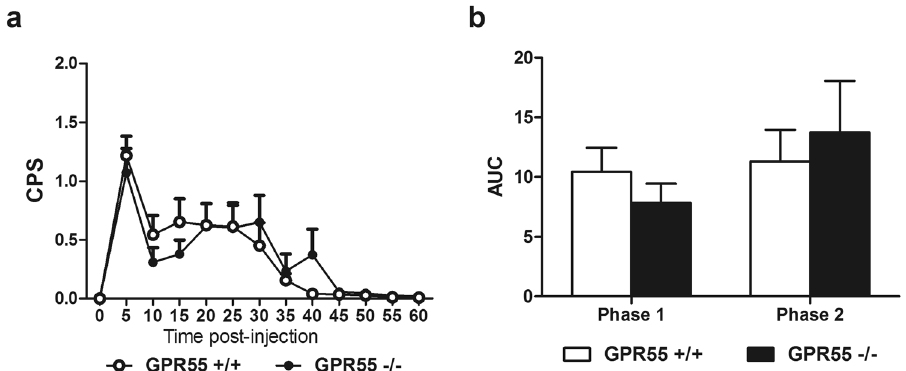
Figure 4. Levels of formalin-evoked nociceptive behaviors do not differ between GPR55 KO and WT mice. GPR55 KO and WT mice display similar levels of pain behavior in response to intraplantar formalin ( a , b ). Data are expressed as mean ± SEM (n = 6 per group). 2-way ANOVA. CPS: composite pain score, AUC: area under the